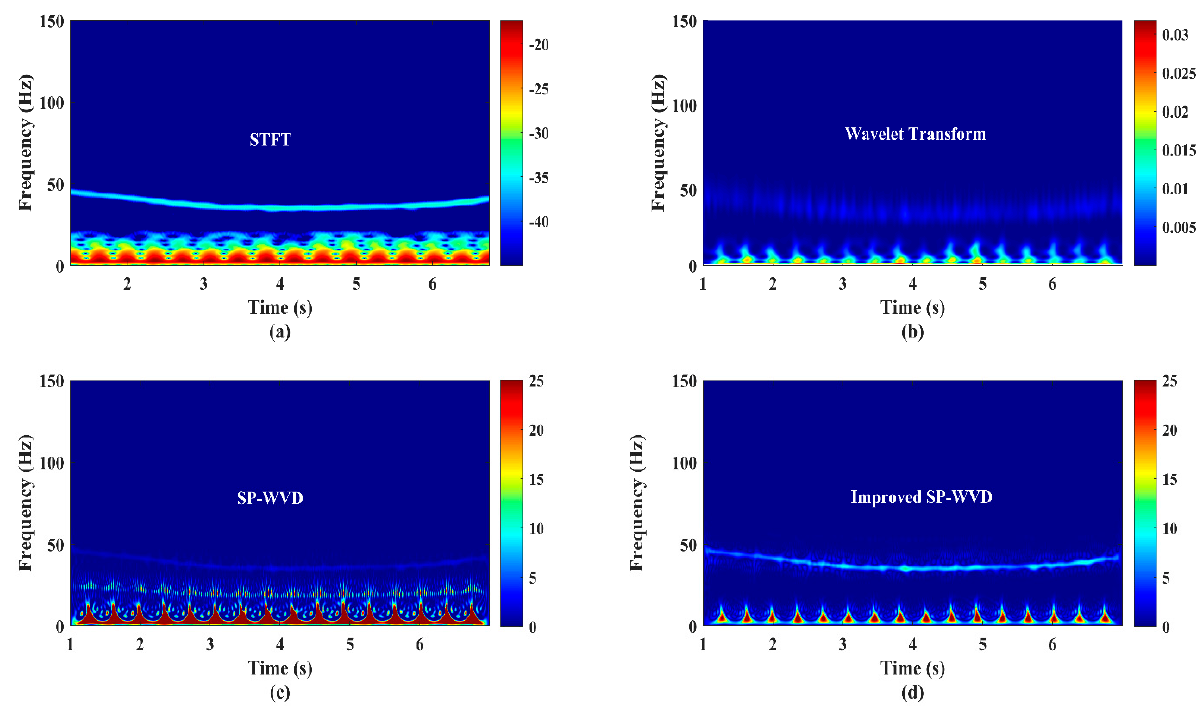
Figure 6. The bionic bird’s sustained − flight action’s and a three − blade rotational propeller system’s micro − Doppler signature/pattern image designed using ( a ) short − term Fourier transform (STFT), ( b ) wavelet transform, ( c ) SP − WVD and, and ( d ) improved SP − WVD.